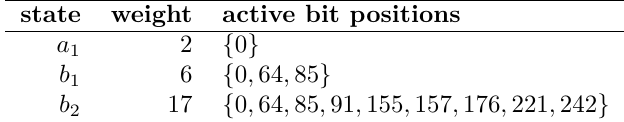
Table 6: 3-round differential trail core with lowest weight.